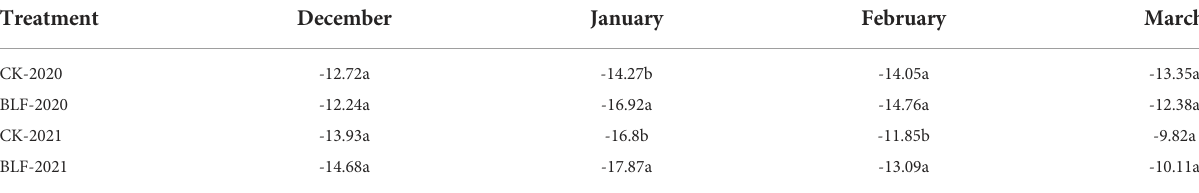
TABLE 3 Effect of spraying BLF on the EL-LT50 value (°C) of one-year-shoots (estimated by relative electrical